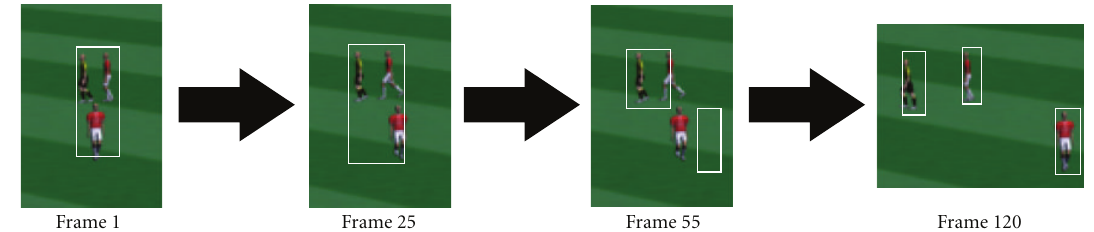
Figure 14: Three players are beginning tracking as one object, and then they